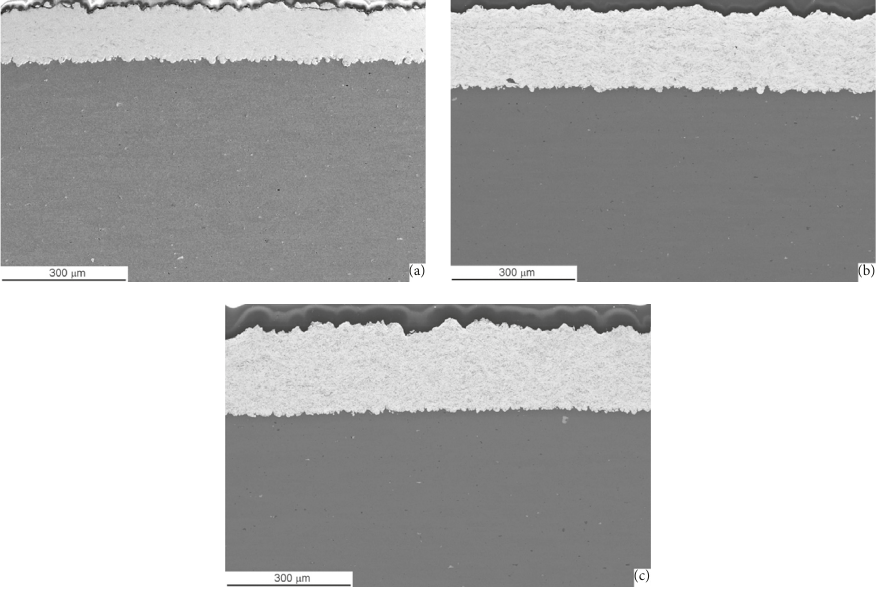
Figure 19: SEM imaging of the cross section of WC-Co coatings: (a)WC-12Co, (b)WC-17Co, and (c)WC-25Co coatings deposited onto the Al 7075-T6 substrate [87].